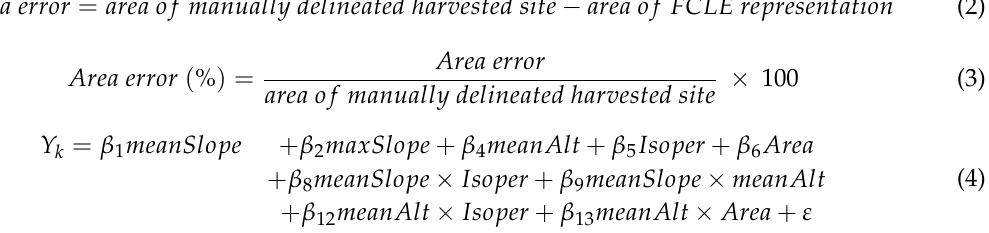
Figure 7. Area distribution and frequency of occurrence of the manually delineated harvested sites to area classes (ha).